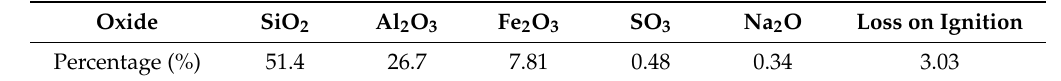
Table 2. Chemical composition of fly ash.